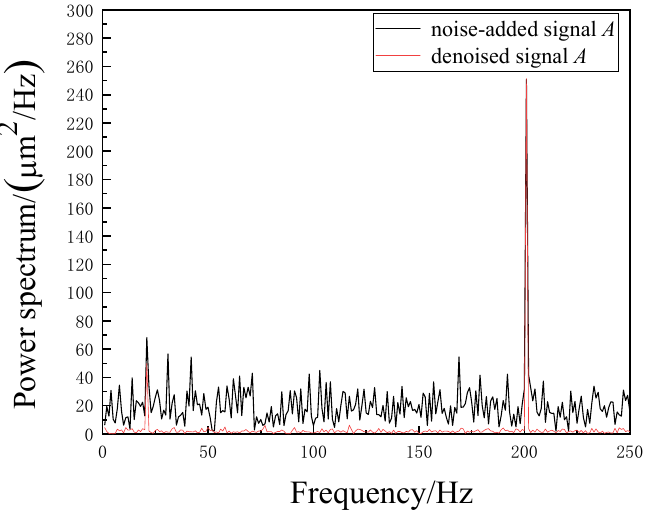
Figure 6. Comparison of the power spectrum before and after noise reduction for the noise-added signal A .